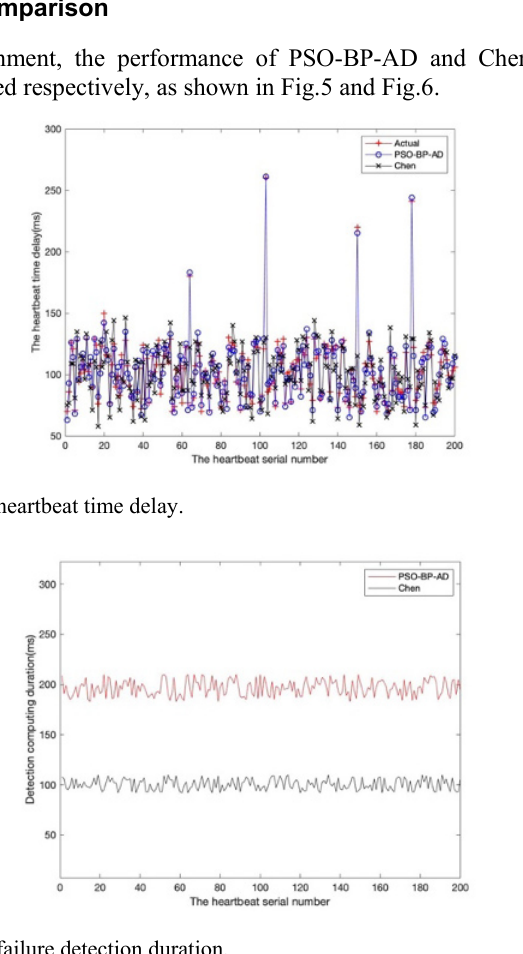
Fig. 6. Comparison of failure detection